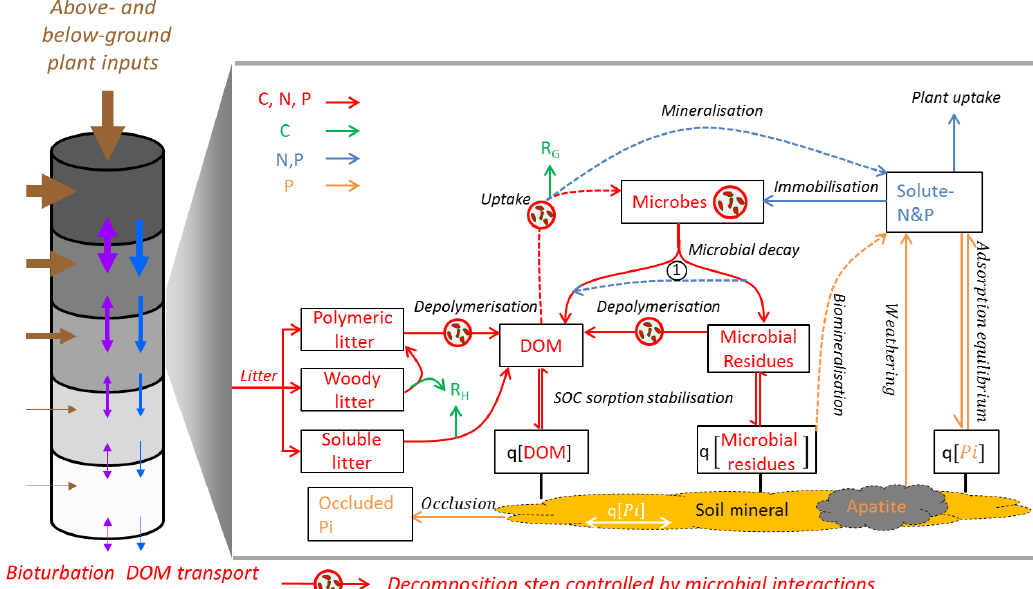
Figure 1. Theoretical representation of Jena Soil Model (JSM) structure. The vertical soil profile (9.5m) is split into 15 soil layers; above- ground litter is added on top of the soil profile; root litter enters into each soil layer according to the root distribution. Bioturbation and DOM transport translocate SOM between soil layers. In each soil layer, boxes refer to pools and lines refer to processes. Red lines: biogeochemical fluxes of C, N and P; green lines: respiration fluxes ( R H for heterotrophic respiration and R G for microbial growth respiration); blue lines: fluxes of N and P; orange lines: fluxes of only P; dashed lines: biogeochemical processes that involves stoichiometry change between the sourcing and sinking pools. The number 1 at the centre (1) indicates microbial nutrient recycling from residue to DOM during decay; q [ X ] : mineral-associated form (adsorbed to soil mineral surface or absorbed into soil mineral matrix) of X , which can be DOM, microbial residues or inorganic phosphate